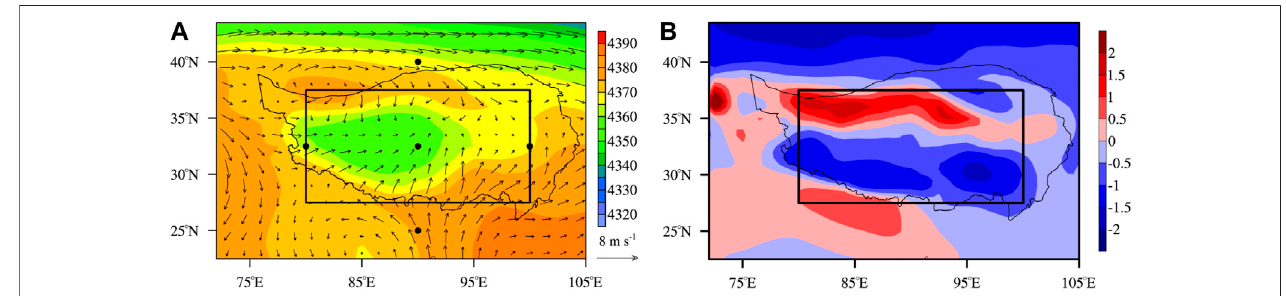
FIGURE2|(A) Multiyearmeancirculation(vectors,unit:ms − 1 )andgeopotentialheight(shadedareas,unit:m)of600 hPainsummer. (B) Multiyearmeanwind fi eld